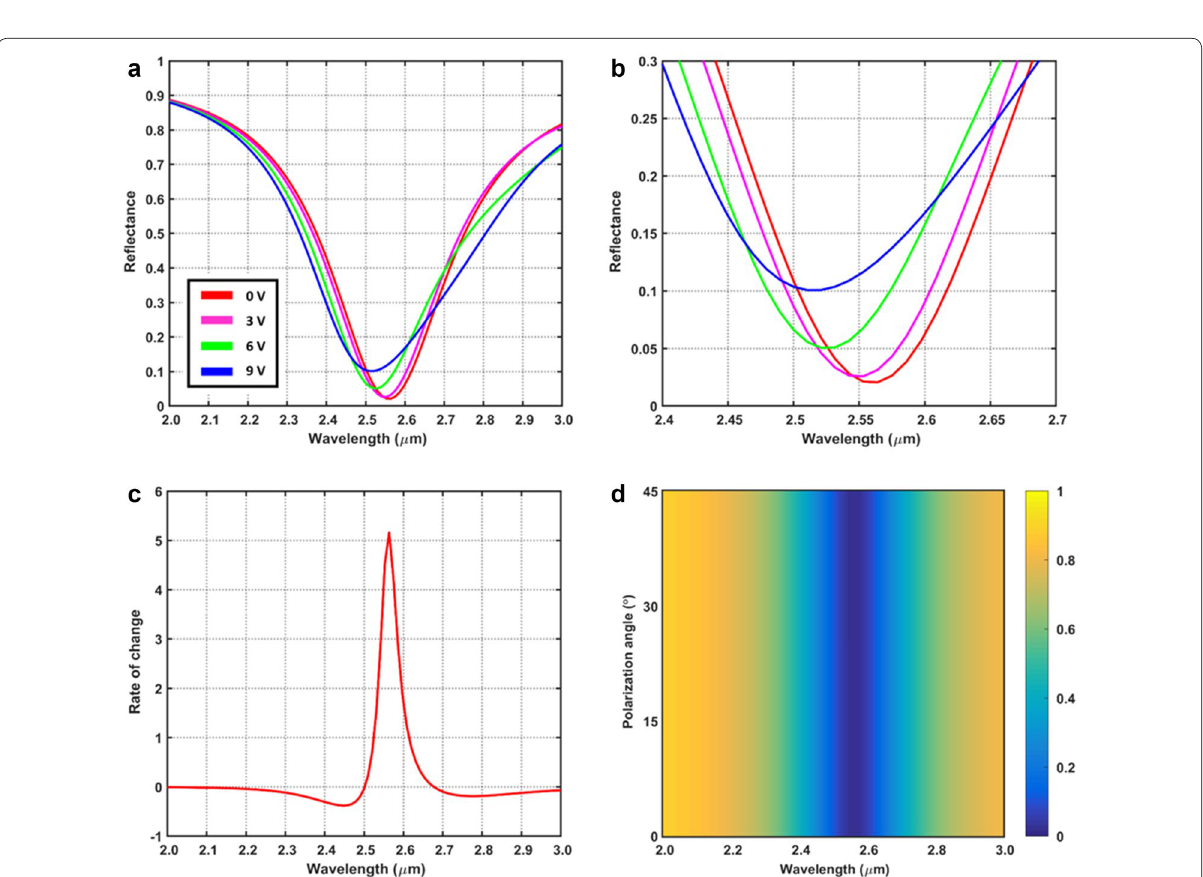
Fig. 5 COMSOL simulation results of device functionality. a Reflection spectra of the device at voltage bias reflection was near λ 2.56 μm at 0 V, and moved 50 nm to the blue at 9 V. b Magnified plot near λ = change based on ( a ). The rate is defined by the reflectance variation divided by the unbiased reflection at each λ , which reaches up to 5.16 near λ 2.56 μm. d Calculated unbiased reflectance result depending on the incident polarization direction from 0° to 45°. The reflectance seldom = changes regardless of polarization direction because of the symmetry of our metasurface pattern